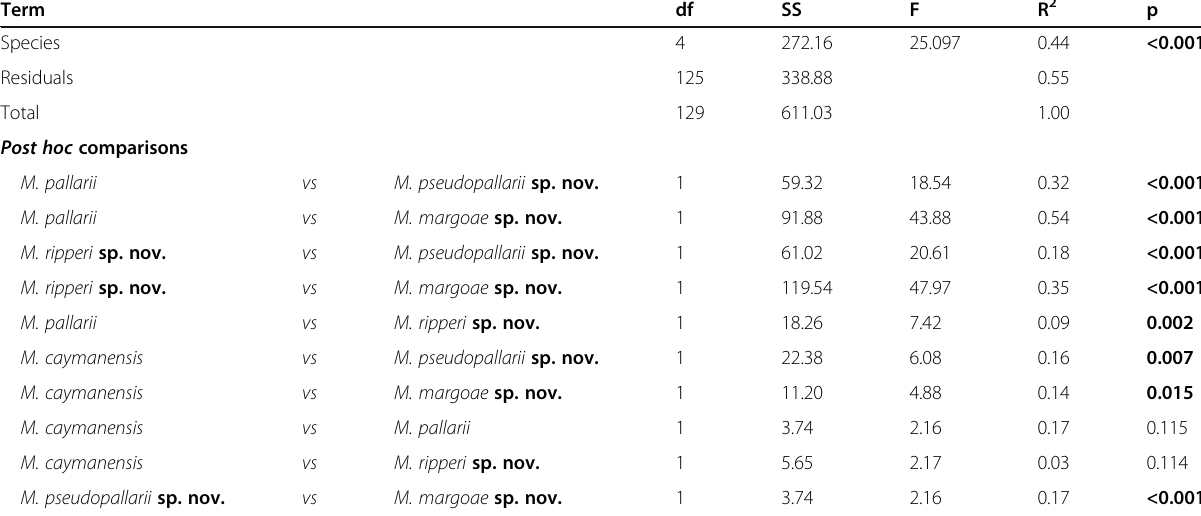
Table 5 Results of PERMANOVA and post hoc pairwise PERMANOVA comparisons for the first two principal components (PCs) of egg measurements; significant post hoc p-values at the α -level of p<0.040 (i.e., adjusted with the Benjamini-Hochberg correction) are in